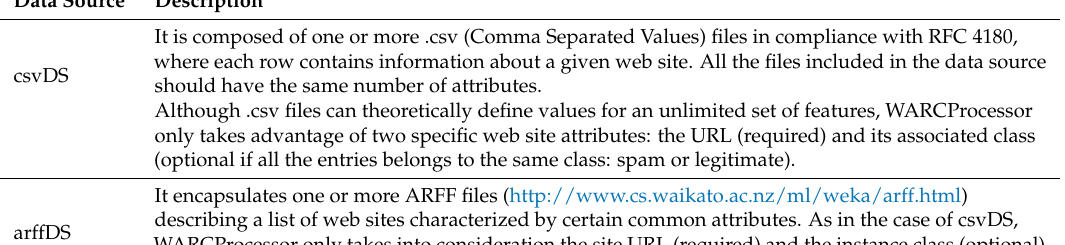
Table 2. Available data sources natively supported by WARCProcessor.